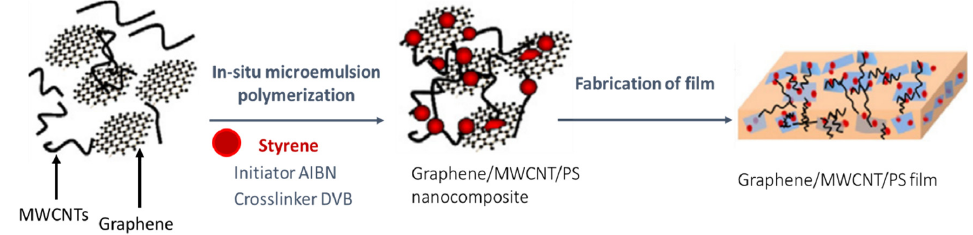
Figure 12. Preparation flow for graphene/MWCNT/PS film using divinylbenzene (DVB) crosslinker (adapted from [7]). (Reprinted from Patole, A.S.; Patole, S.P.; Jung, S.-Y.; Yoo, J.-B.; An, J.-H.; Kim, T.-H. Self